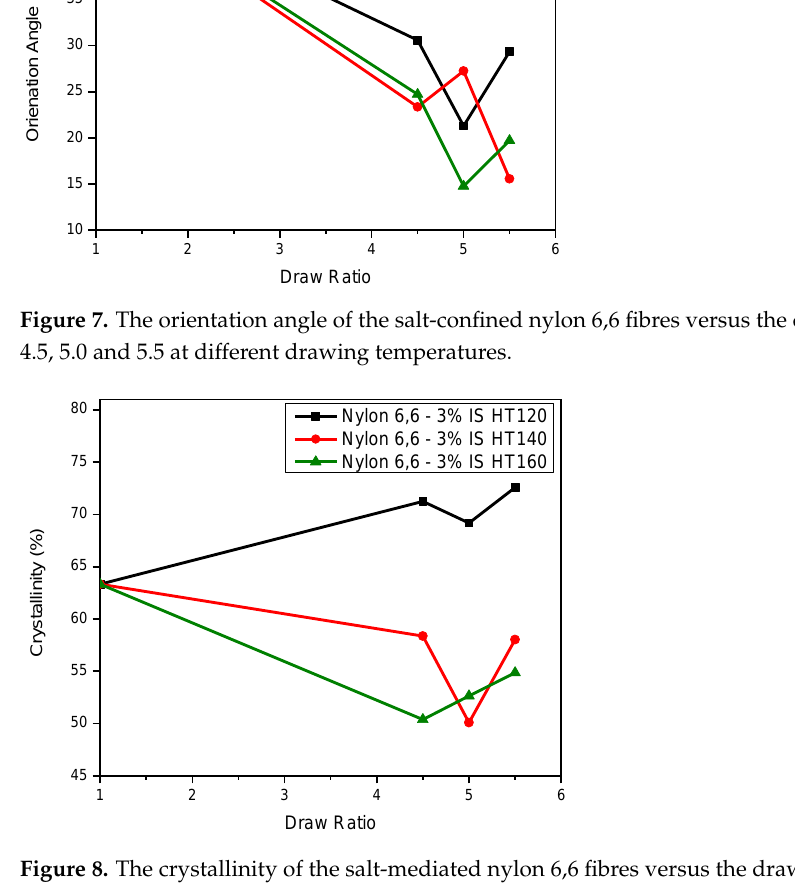
Figure 8. The crystallinity of the salt-mediated nylon 6,6 fibres versus the drawing ratios of 1.0, 4.5, 5.0 and 5.5 at different drawing.